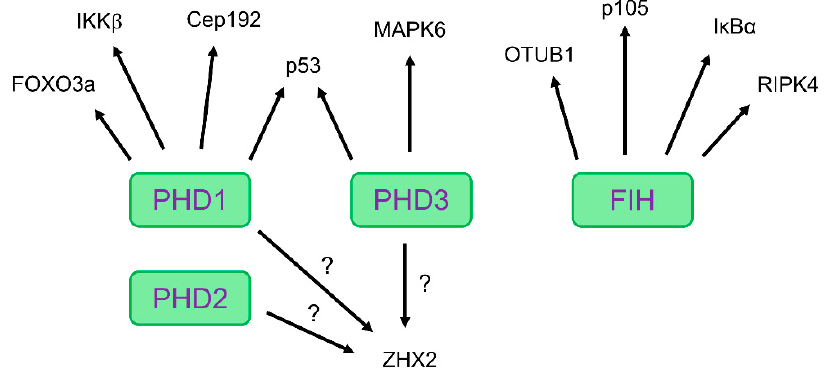
Figure 4. Schematic overview of alternative targets other than HIF mediated by HIF prolyl hydroxylases (PHD) 1, 3 or factor inhibiting HIF (FIH). PHD1-mediated hydroxylation: Forkhead box O3a (FOXO3a), I κ B kinase- β (IKK β ) and centrosomal protein 192 (Cep192). PHD1- and 3-mediated hydroxylation: Tumor suppressor protein 53 (p53). PHD3-mediated hydroxylation: Mitogen-activated protein kinase 6 (MAPK6). FIH-mediated hydroxylation: Ovarian tumor domain containing ubiquitin aldehyde binding protein 1 (OTUB1), NF- κ B precursor (NFKB1; p105), I κ B α and receptor interacting serine/threonine kinase 4 (RIPK4). PHD-mediated hydroxylation: Zinc fingers and homeoboxes 2 ( ZHX2).